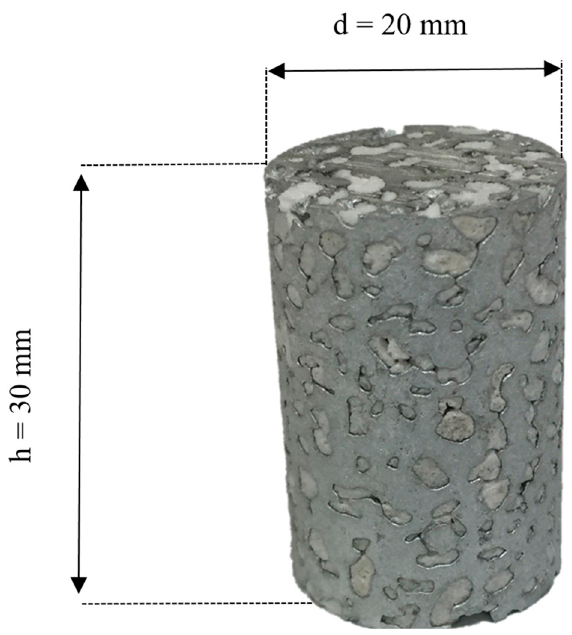
Figure 1. Cylindrical ZA27—Expanded perlite syntactic foam sample.